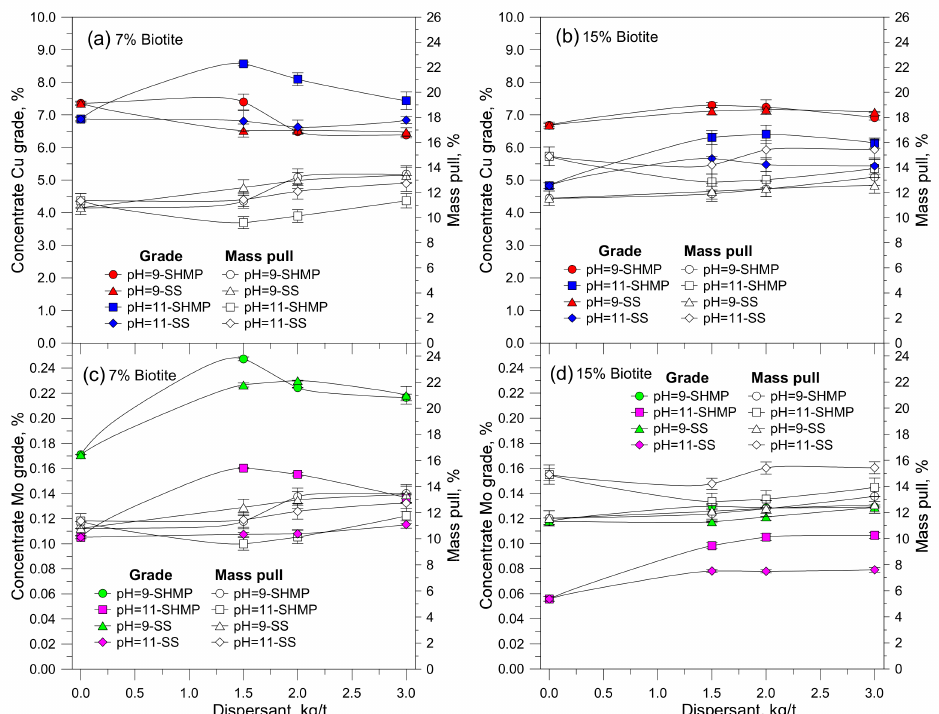
Figure 5. Copper ( a , b ) and molybdenum ( c , d ) concentrate grades and mass pull in seawater at pH 9 and 11, as a function of dispersant dosage (SHMP, SS) and two biotite